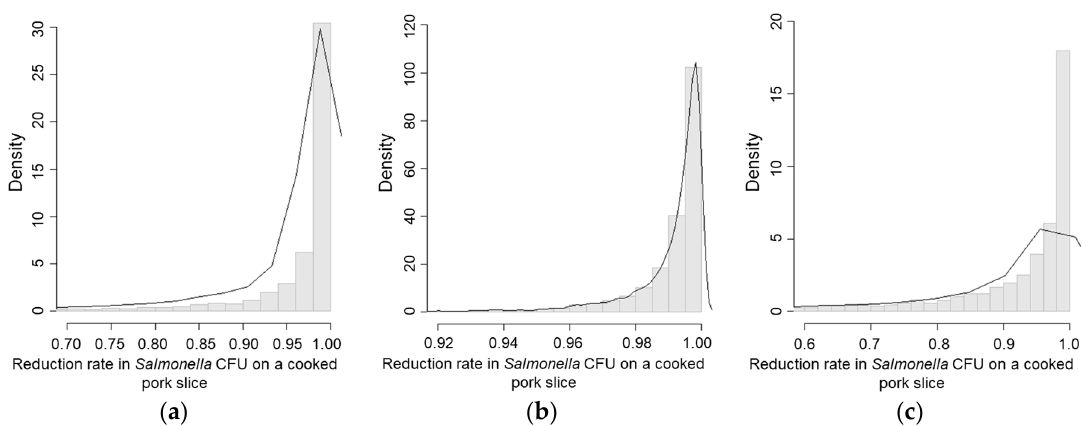
Figure 5. Reduction rates after Salmonella cross-contamination to cooked pork slice. ( a ) Scenario 1—Washing hands, the knife and the cutting board; ( b ) Scenario 3—Using a new cutting board, disinfecting hands, and washing the knife; ( c ) Scenario 4—Using a new knife, disinfecting hands, and washing the cutting board.